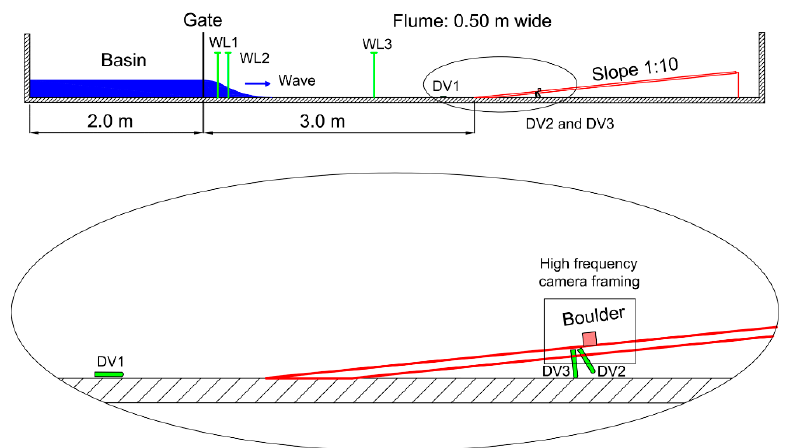
Figure 1. Experimental setup: The generated flow moves from left to right after the opening of the gate. The water level sensors WL1, WL2, WL3 are placed at the respective horizontal distances of 0.16, 0.28, and 1.94 m from the gate. The Doppler ultrasound velocimeter DV1 is placed at 2.7 m from the gate and at 0.4 m from the slope base, pointing at the incoming bore. DV2 and DV3 are placed at the distance of 1.09 m along the slope with respect to the slope base. The boulder is located 2 cm away from the DV2 and DV3 upslope.